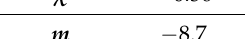
Figure 7. Plastic parameter A for quasi ‐ UD E ‐ glass/polypropylene composite under different effective plastic strain rate. Table 3. Material parameters for quasi ‐ UD E ‐ glass/polypropylene composite in Equation (14). (cid:2257) χ −